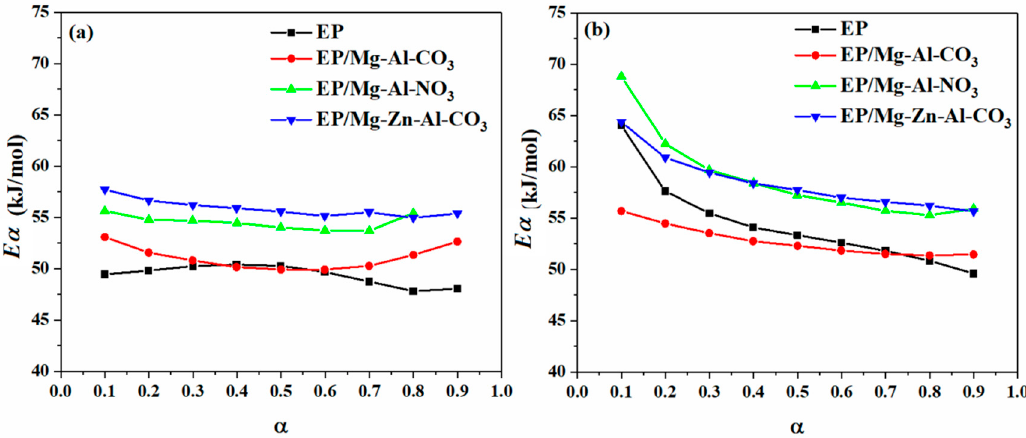
Figure 3. Variation of activation energy for EP, EP/Mg-Al-CO 3 , EP/Mg-Al-NO 3 and EP/Mg-Zn-Al-CO 3 nanocomposites obtained by ( a ) differential Friedman and ( b ) integral KAS models.